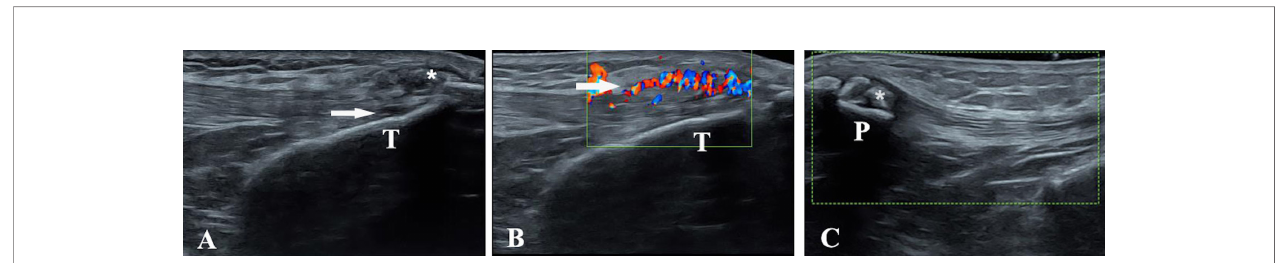
FIGURE 1 | Ultrasound evaluation in gouty patients. Longitudinal scans of the patellar ligament and the quadriceps tendon in B-mode and power Doppler ultrasound. (A) The asterisk shows the tophus of the patella ligament. (B) Doppler fl ow signals indicate acute in fl ammation of quadriceps tendon. (C) The asterisk shows the tophus of the quadriceps